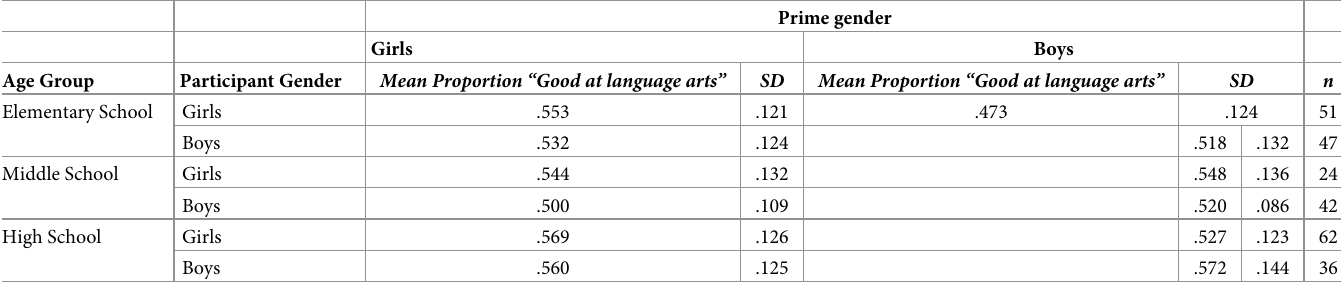
Table 2. Language implicit bias scores by age group, participant gender and prime